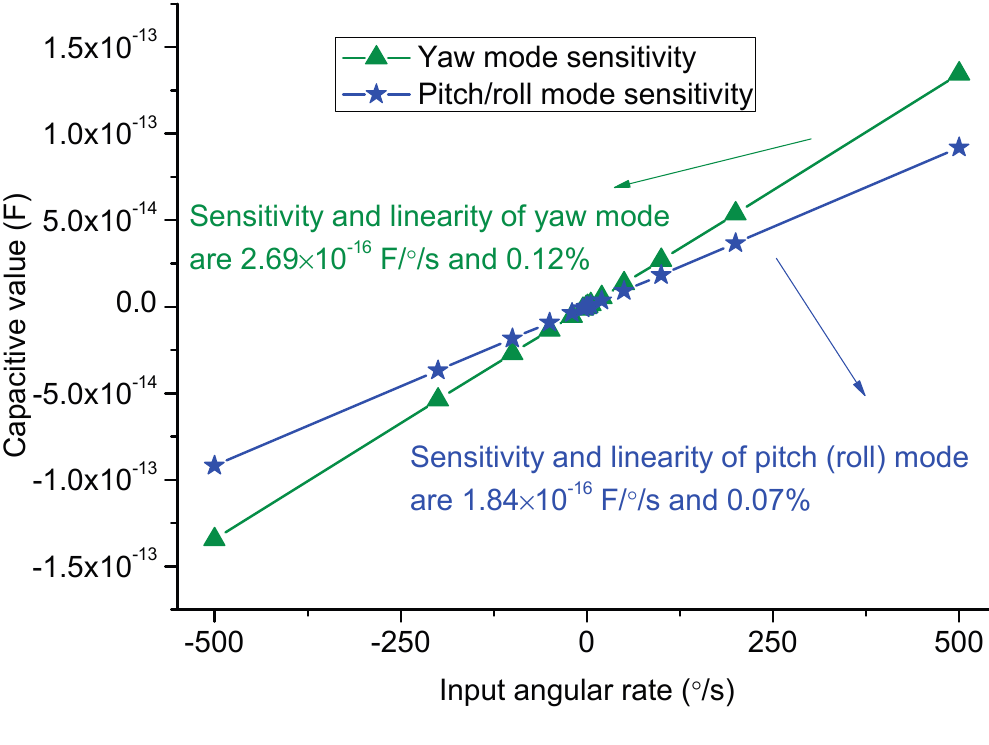
Figure 12. Sensitivity simulation results.